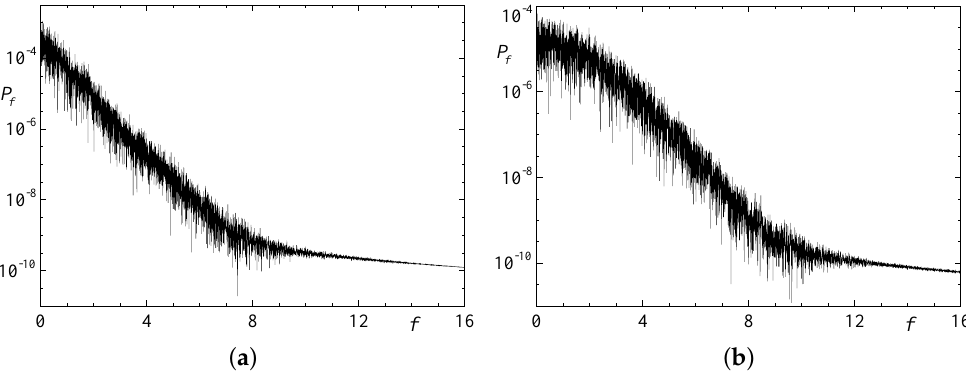
(b) in run 2 x 4.2. (a) and Re ˆ v 1 222 111